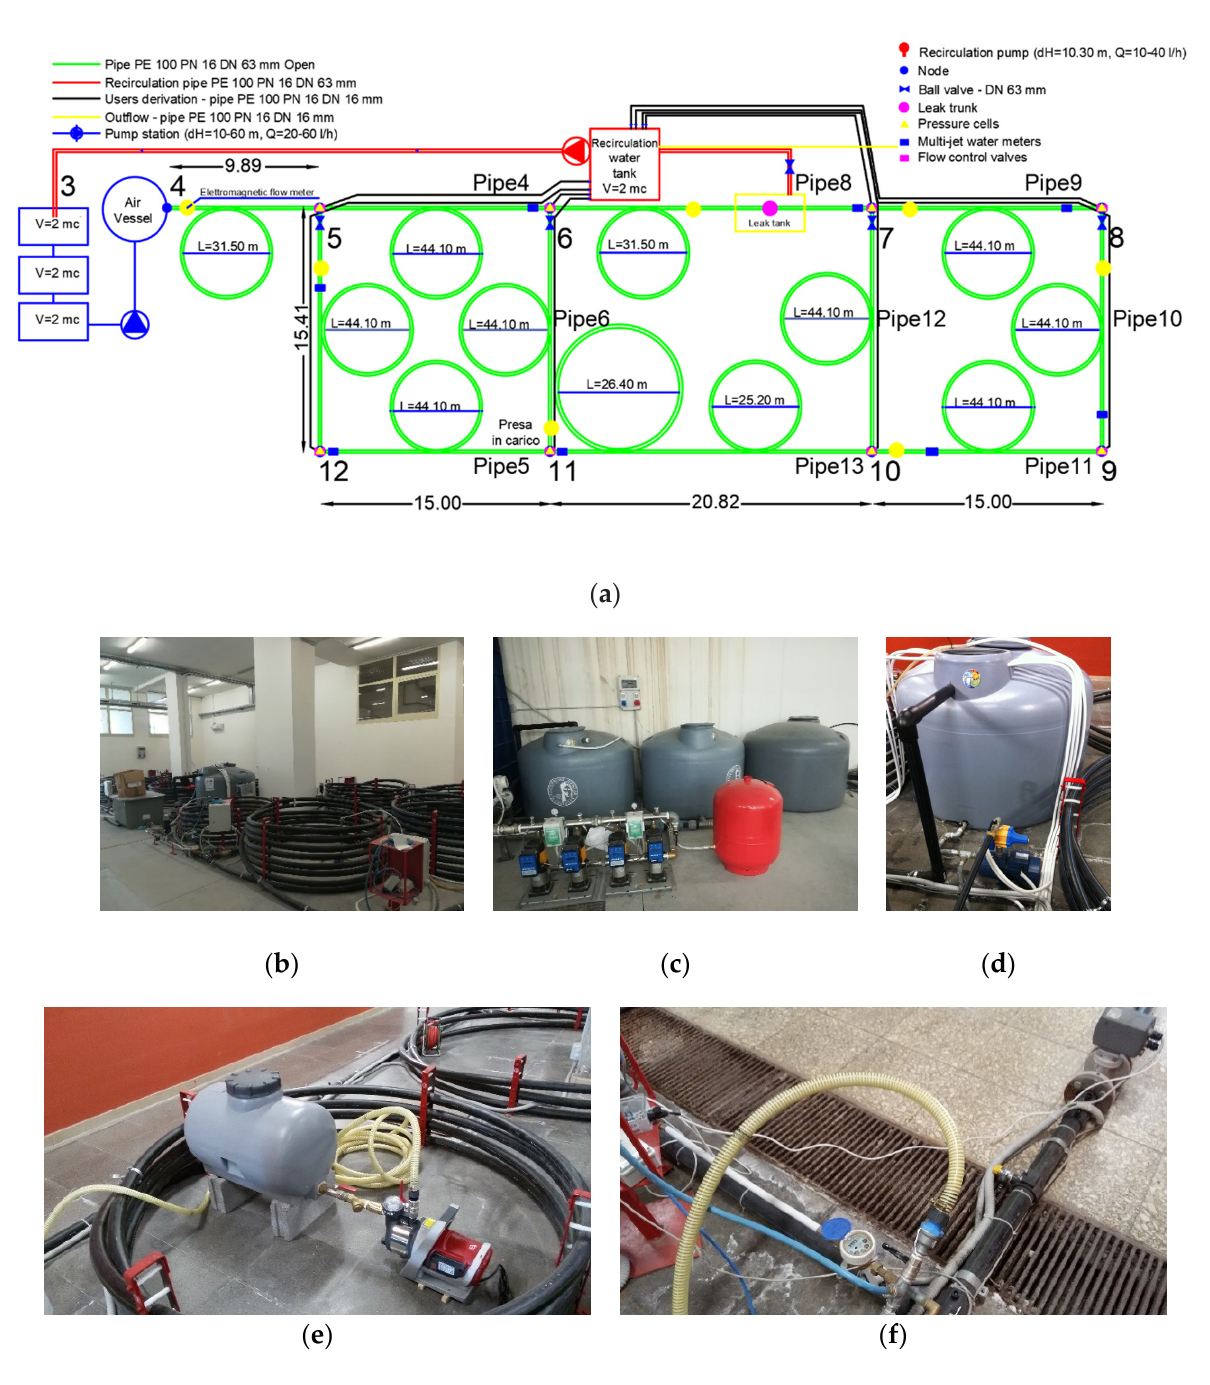
Figure 1. The layout of the water distribution network ( a ), overview of the water distribution network ( b ), pumping system ( c ), recirculation system ( d ), installation of the pump-reservoir system ( e ) and connection to the node ( f ).